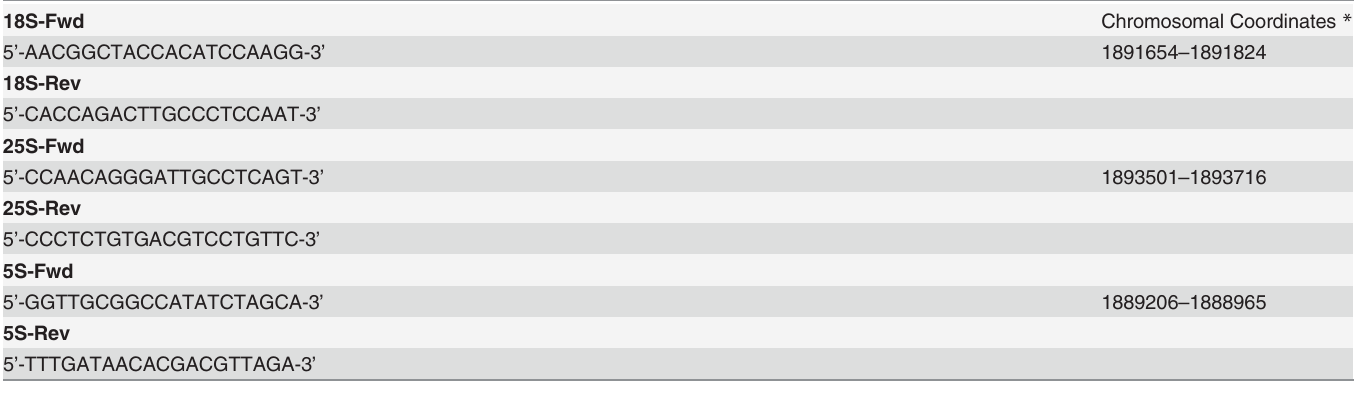
Table 2. Primer sequences for RT-PCR.